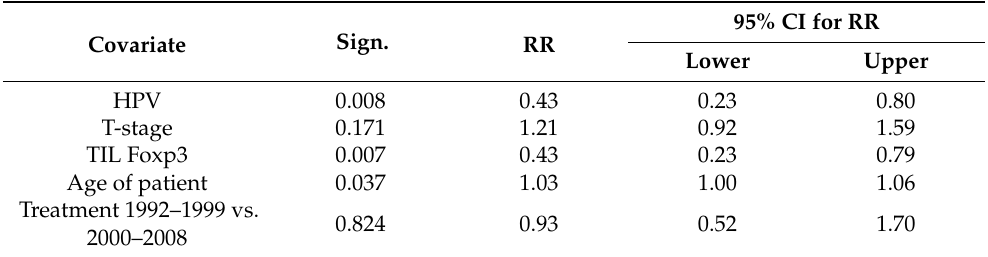
Table 7. Cox regression multivariate disease-specific five-year survival analysis including HPV tumor status, T stage, epithelial levels of Foxp3-positive cells and diagnosed 1992–1999 (treatment mainly RT only) versus 2000–2008 (treatment mainly surgery with postop RT). Covariate